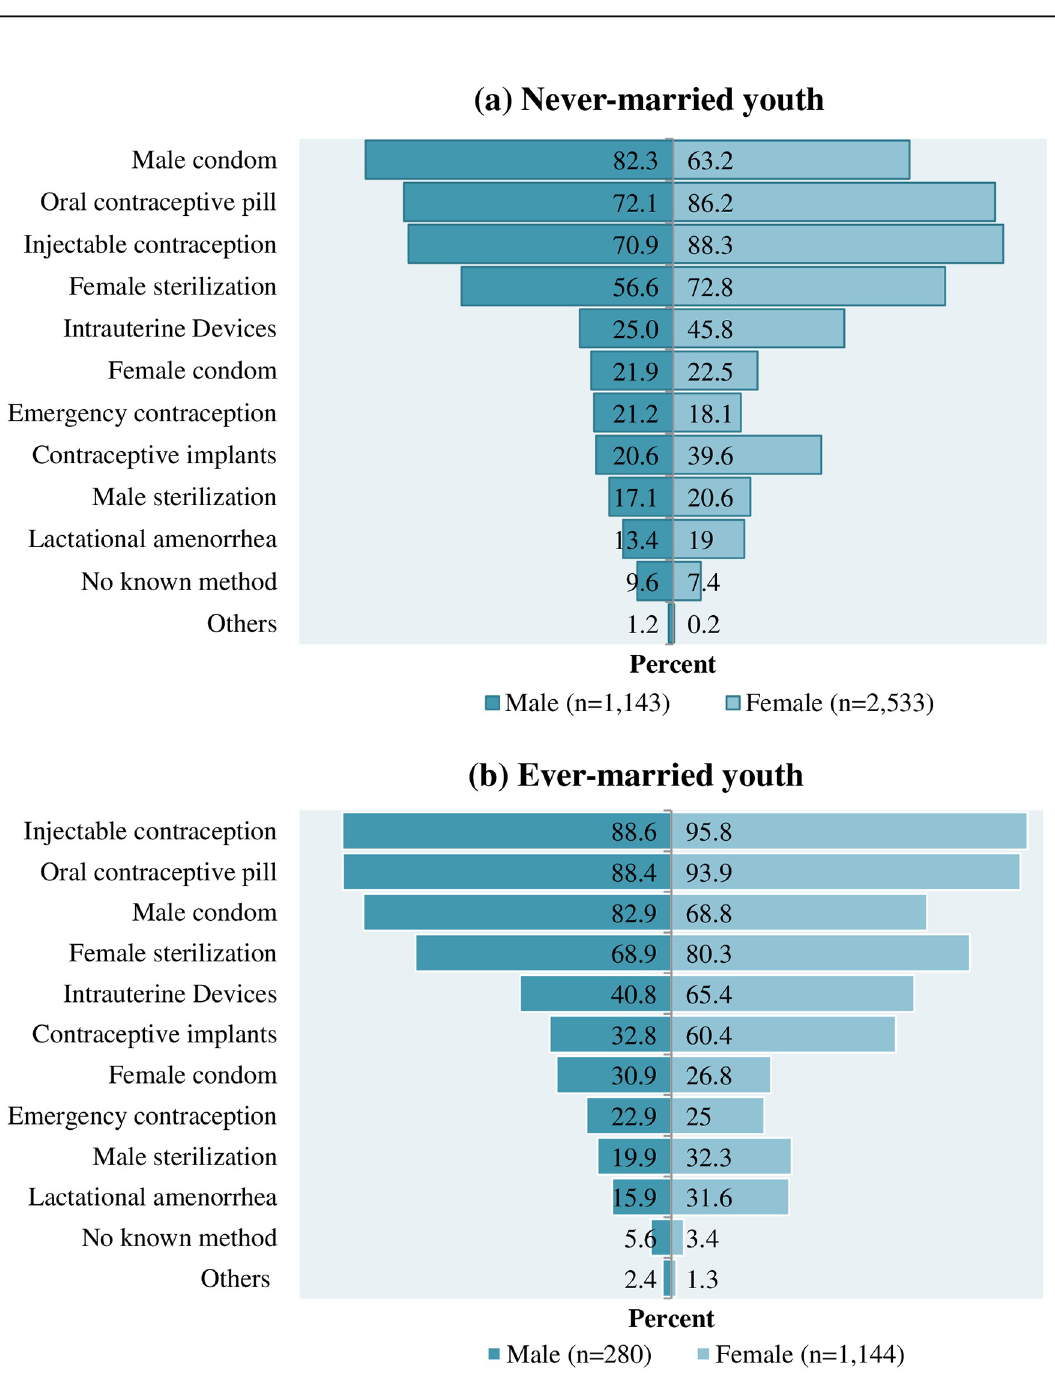
Fig 1. Types of modern contraceptive methods known by youth in